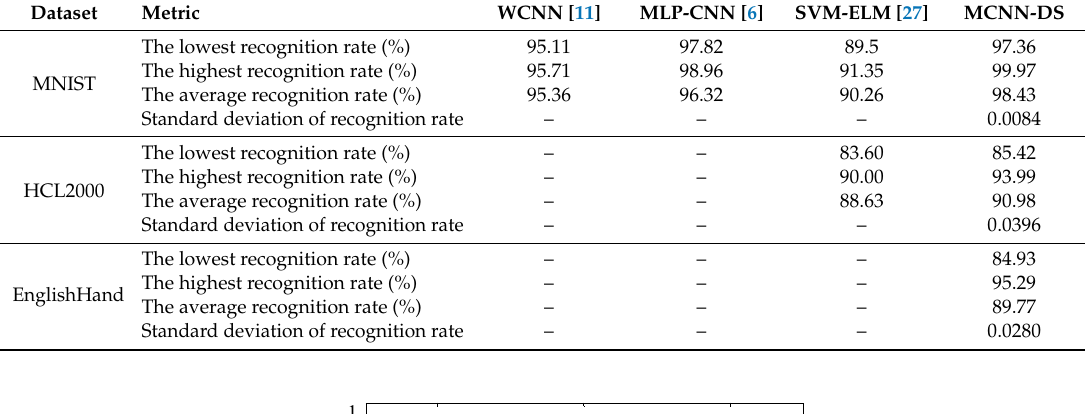
Table 2. Algorithm recognition performance comparison.